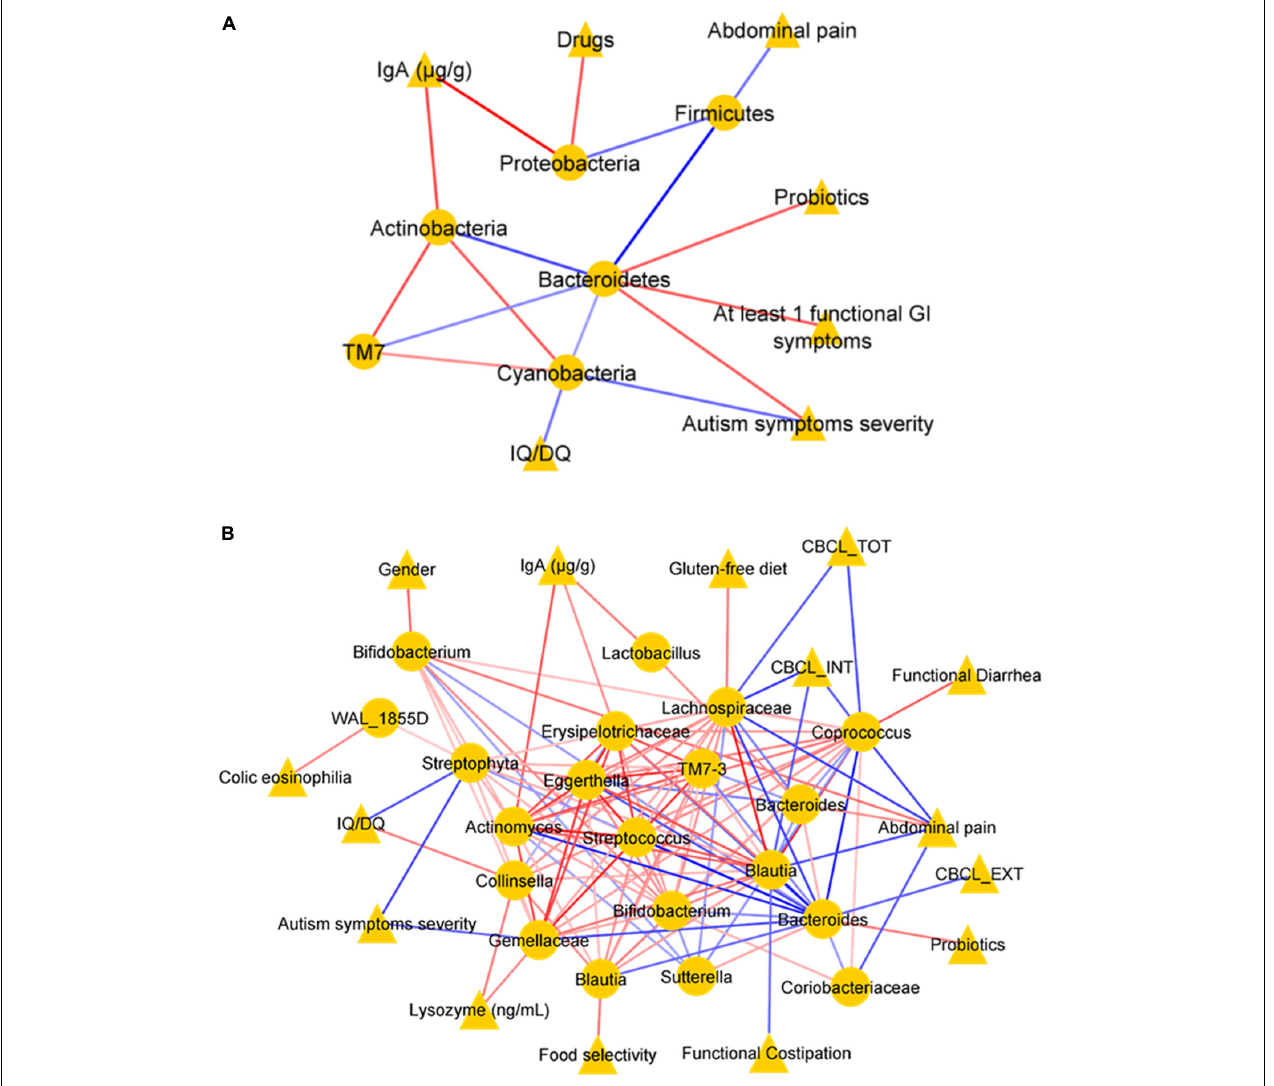
FIGURE 9 | Correlation networks. Correlation analysis between OTUs (selected with the t -test with p -value ≤ 0.05) and clinical variables at the phylum level (L2) (A) and at the genus level (L6) (B) . In each network, nodes represent the OTUs (circles) and the clinical variables (triangles), and an edge between two nodes occurs if they exhibit a statistically significant correlation ( p -value ≤ 0.05). The color of the network edges indicates positive (red) and negative (blue)